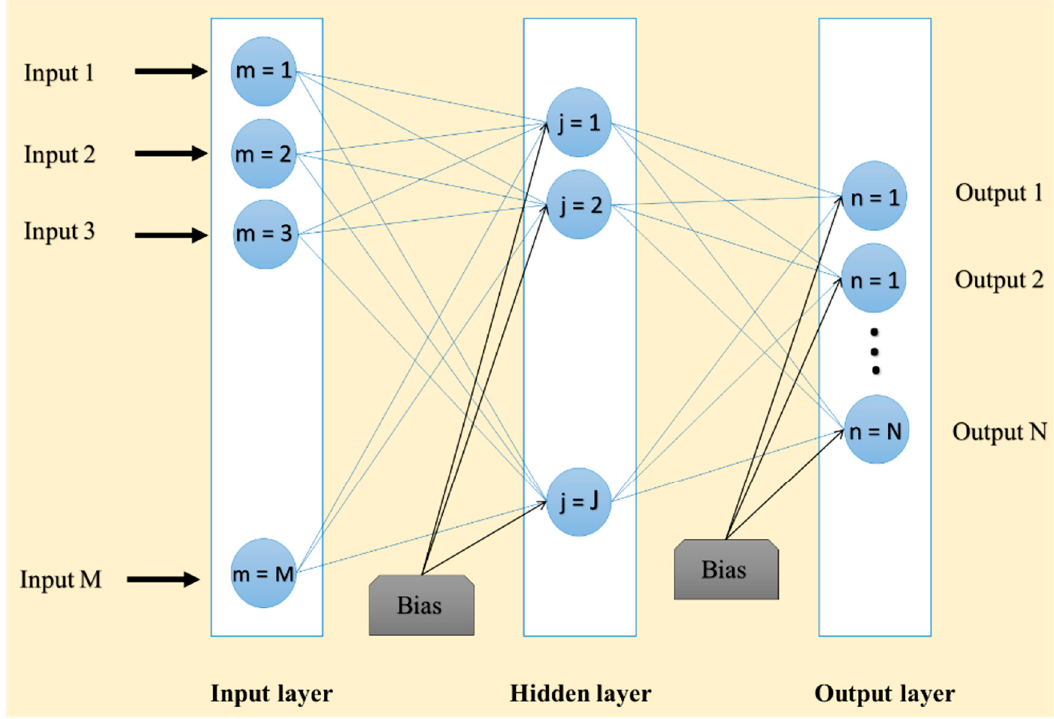
Figure 2. Typical structure of the multi-layer perceptron (MLP).